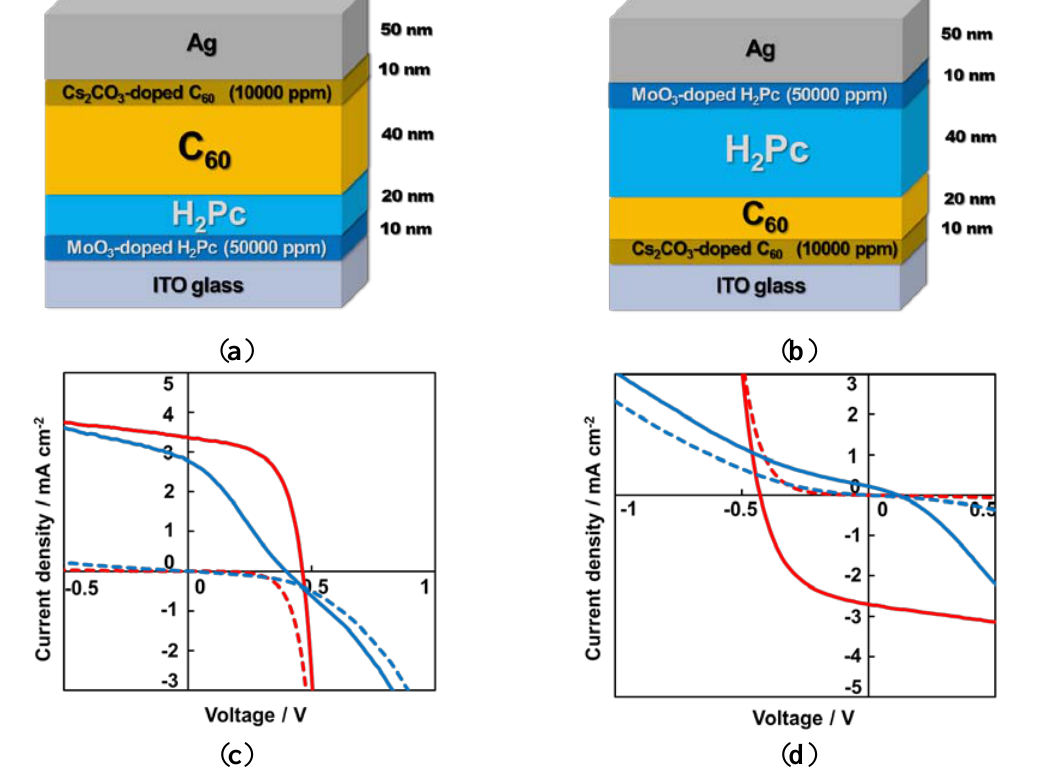
Figure 21. Structures of invertible two-layered H Pc/C cells with heavily-doped 2 60 organic/metal interfaces. For the cells in ( a , b ), photogenerated holes and electrons are extracted to ITO and Ag, and to Ag and ITO, respectively. The total thicknesses of the H Pc and C films are kept the same; ( c , d ) Current-voltage (J-V) characteristics for the 2 60 cell ( a , b ) (red curves). The blue curves are for cells without heavily doped interfaces. The photocurrent and the dark current are shown by the solid and broken curves, respectively. The ITO electrode was irradiated with simulated solar light (AM1.5, 100 mWcm −2 ). Cell performances: ( a ) J : 3.38 mAcm −2 , V : 0.46 V, FF: 0.59, Efficiency: 0.91%; sc oc : 2.70 mAcm −2 , V : 0.43 V, FF: 0.49, Efficiency: 0.57%. Copyright © 2012 The ( b ) J sc oc